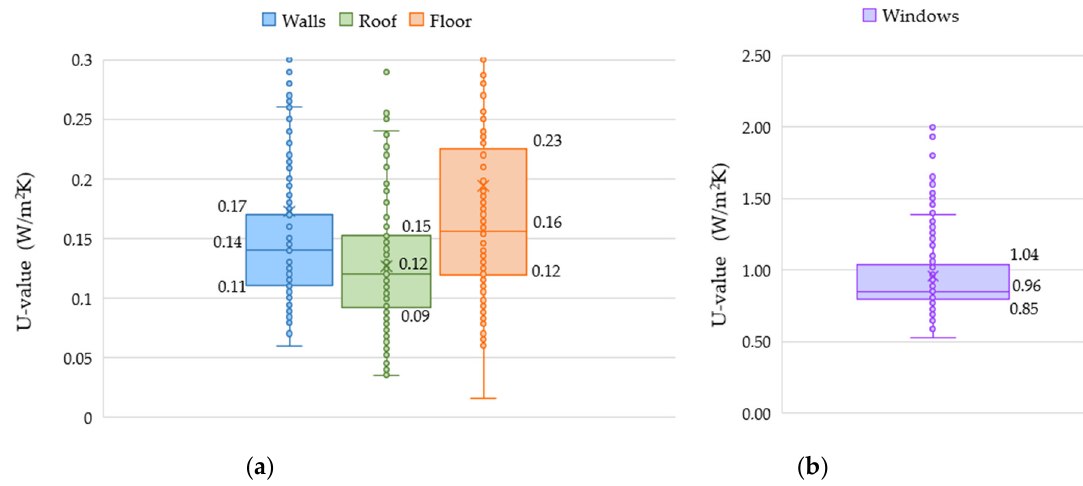
Figure 8. Thermal transmittance of walls, roofs, floors ( a ) and windows ( b ).